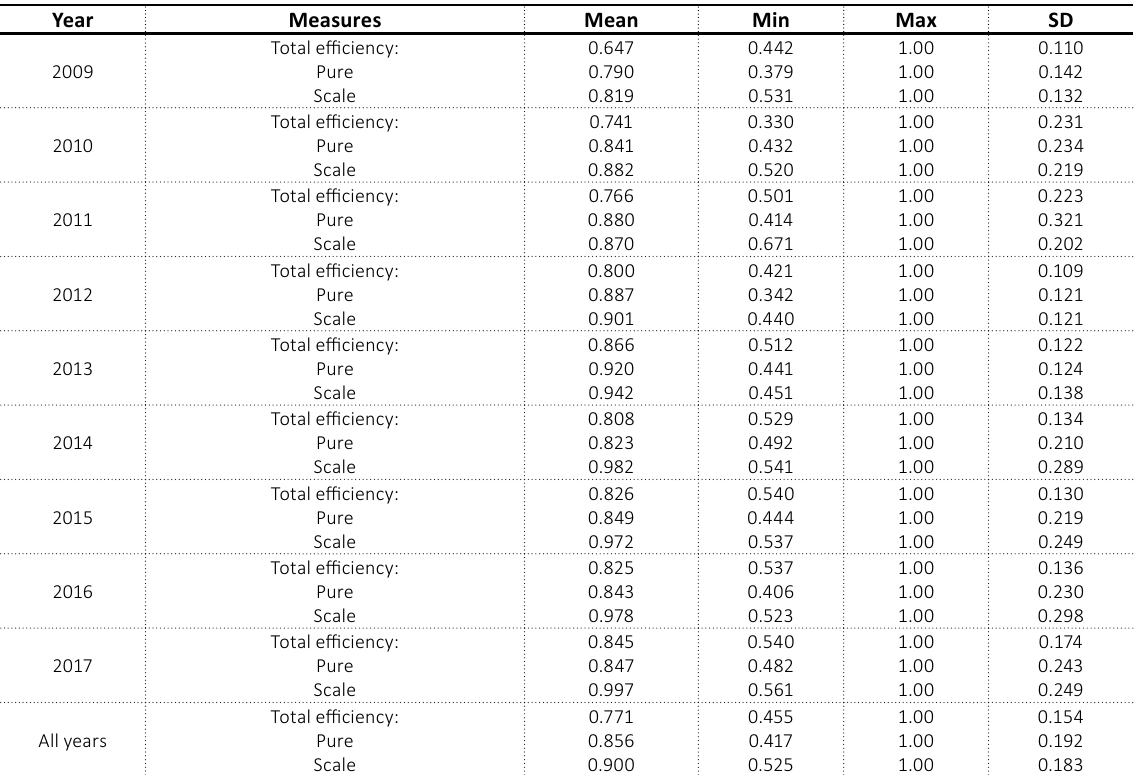
Table 9. Measures of efficiency of conventional banks after the crisis